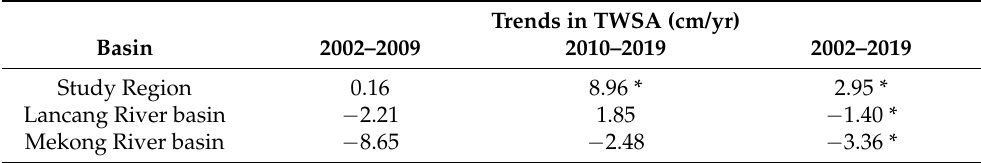
Figure 4. Temporal variations of GRACE-derived total water storage anomalies (TWSA) in ( a , b ) Xiaowan and Nuozhadu reservoirs basin, ( c , d ) Lancang River basin, and ( e , f ) Mekong River basin. LOESS trend is the de-seasonalized TWSA using the LOESS (locally estimated scatterplot smoothing) method. The gray bars indicate the intermission gap between GRACE and GRACE-FO. Table 2. The total water storage anomaly (TWSA) trends derived from GRACE in the lower Lancang River basin, Lancang River basin, and Mekong River basin.